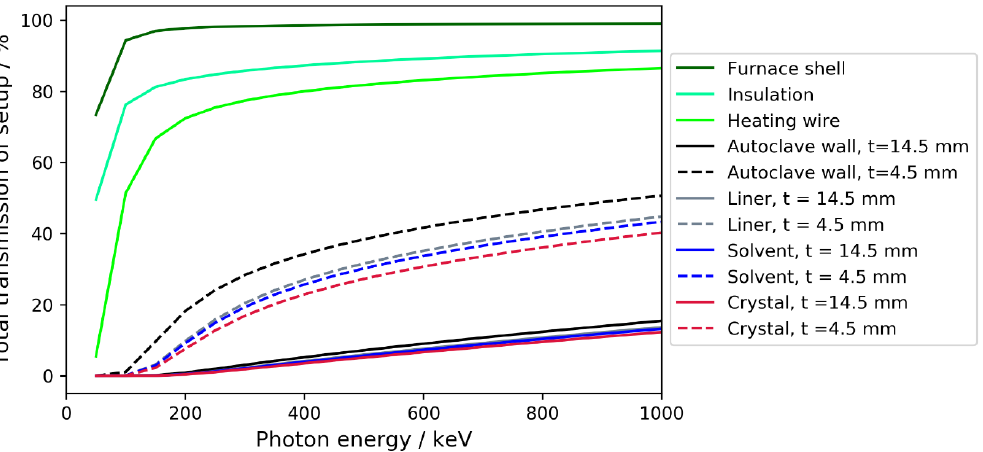
Figure 1. Calculated total X-ray transmission of an exemplary ammonothermal growth setup in two variants differing by the autoclave wall thickness t as a function of X-ray photon energy. The absence of data below 50 keV originates from calculating data at an interval of 50 keV starting at 50 keV. Total transmission would approach zero for photon energies approaching zero. Table 3. Components of the experimental setup considered for the calculation results presented in Figure 1. Minor simplifying assumptions used in the calculations can be seen from the comparison of the columns ”Material in Experiment” and “Material in